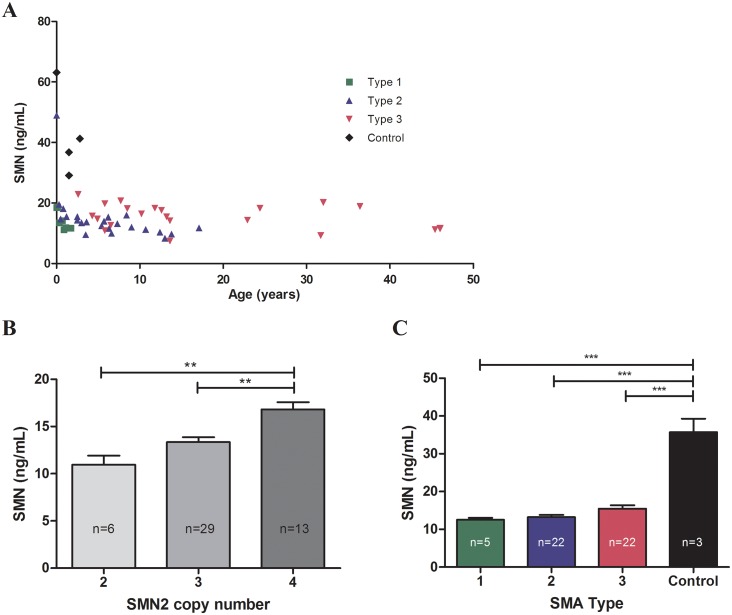
SMN protein levels in SMA patient and control whole blood samples.(A) SMN levels with respect to age in all subjects. (B) SMN protein levels were measured in SMA patients with 2, 3 and 4 copies of SMN2. In patients over 2 months of age, SMN levels were significantly greater in SMA patient samples with 4 SMN2 copies relative to those with 2 and 3 SMN2 copies (p = 0.0001). (C) SMN was also measured in three control samples and SMN levels were found to be significantly greater in the control samples relative to levels in SMA patients over 2 months of age (p < 0.0001).